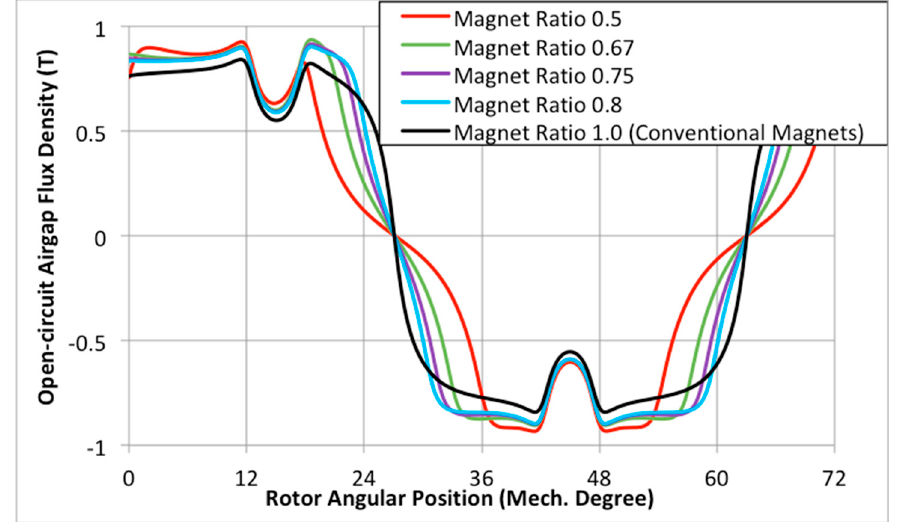
Figure 7. Comparison of Analytically Predicted Air-gap Flux Density with Different Magnet Ratio Values.